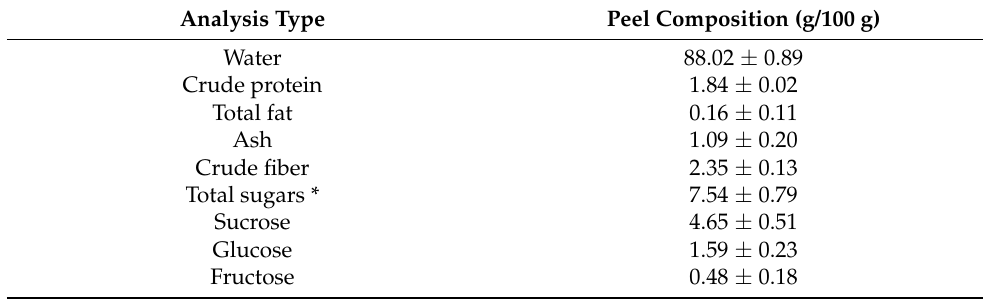
Table 2. Proximate chemical composition of beetroot peels (g/100 g). Analysis